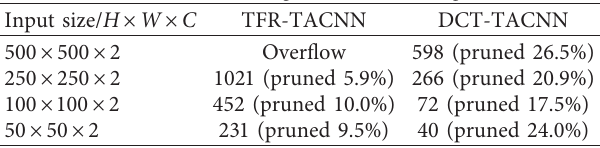
Table 5: Time consuming in model training (unit: